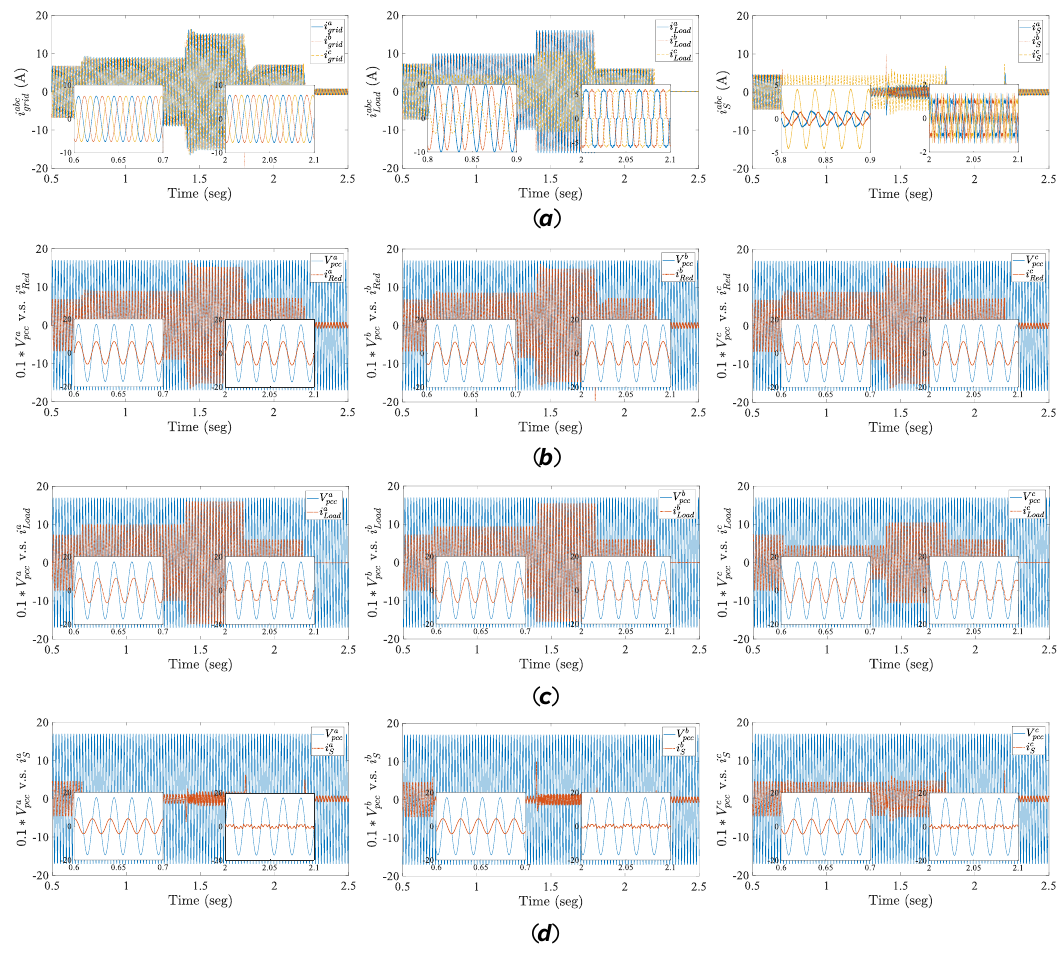
Figure 13. PI controllers dynamical performance comparison: ( a ) i d s , ( b ) i q s , ( c ) i 0 s , and ( d ) v DC